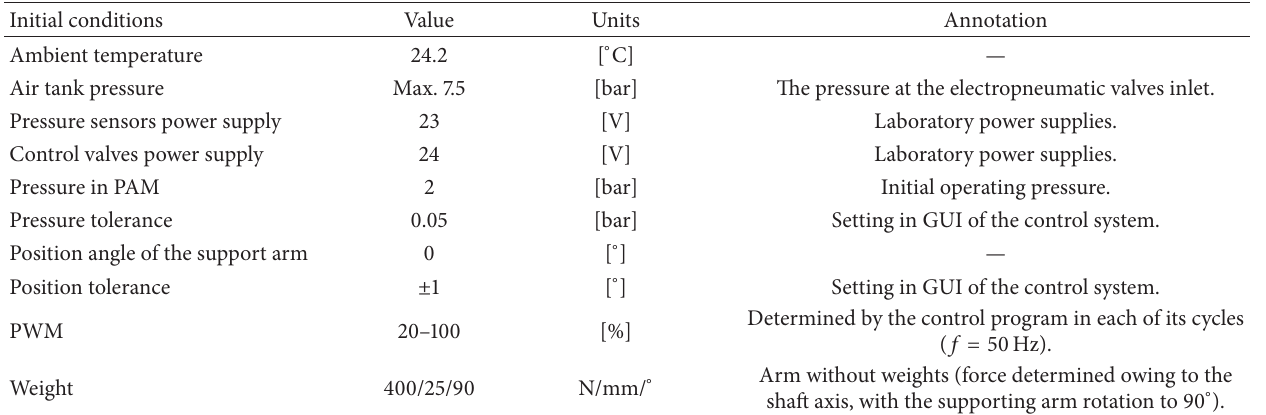
Table 2: Initial conditions and constant parameters for experimental measurements.